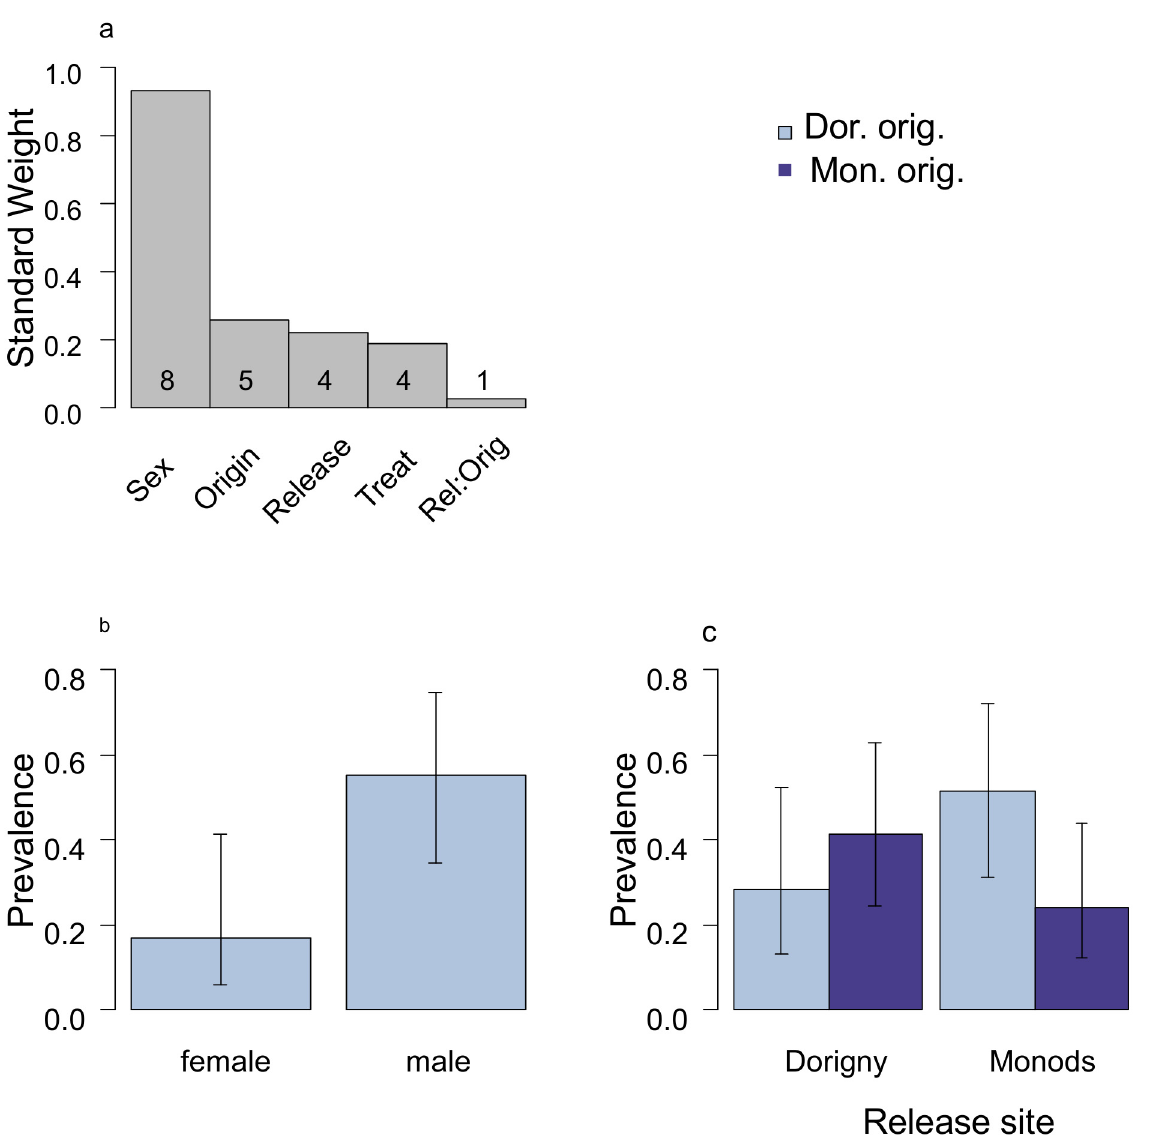
Fig 2. The factors that affect the likelihood of infection by the end of the experimental period. a) The standard weight of parameters in the 95% confidence interval model set and the number of candidate models that they occur in after model averaging. b) The analysis repeated on the original scale and predicted prevalence ± 1 se for males and females. c) Exploring the direction of the target effect, LA, by explicitly keeping the LA parameter in all models. Under a scenario of parasite adaptation, we expect parasites to be more infective on local hosts. Prevalence is plotted on the original scale. For further details of the method see Fig